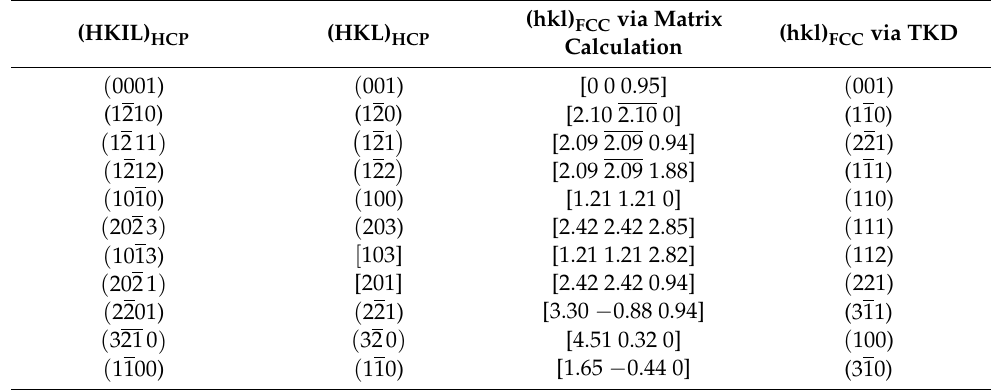
Table 2. Parallel crystal orientation indexes predicted by transformation matrix and PFs.